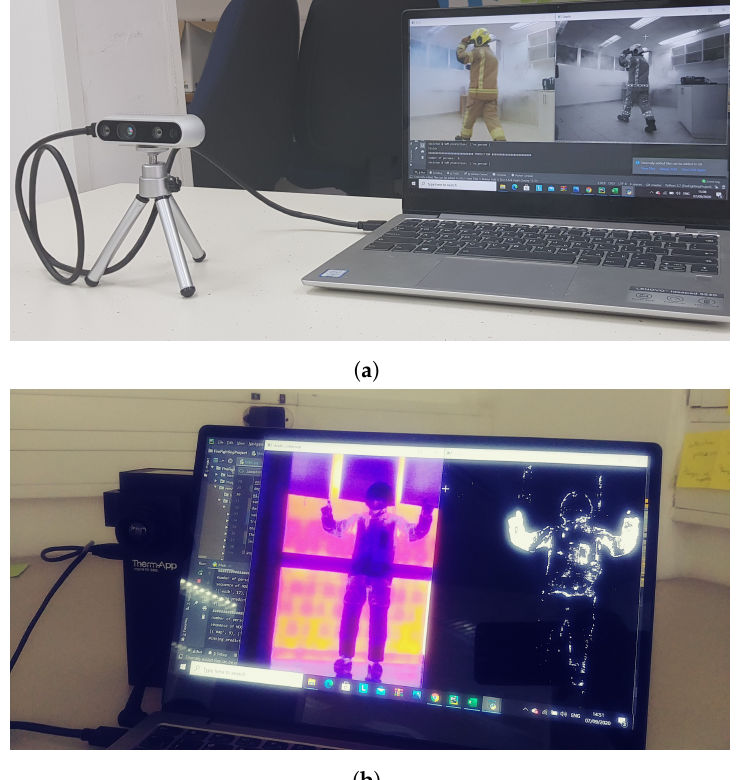
Figure 7. Examples of the setup used in the evaluation of our system. The person is wearing protective firefighting equipment and smoke is starting to be generated. ( a ) The Realsense camera feed is shown on the laptop. ( b ) The raw thermal sensor feed is shown on the left side of the laptop’s screen and, on the right side of the laptop’s screen, the feed is shown after background subtraction.